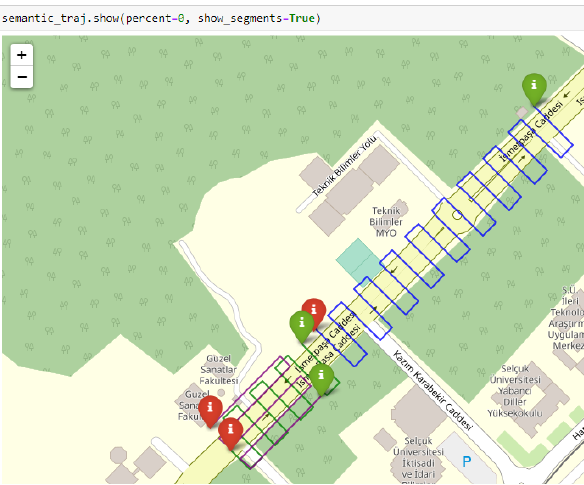
Figure 13. Visualization of a segmented trajectory.